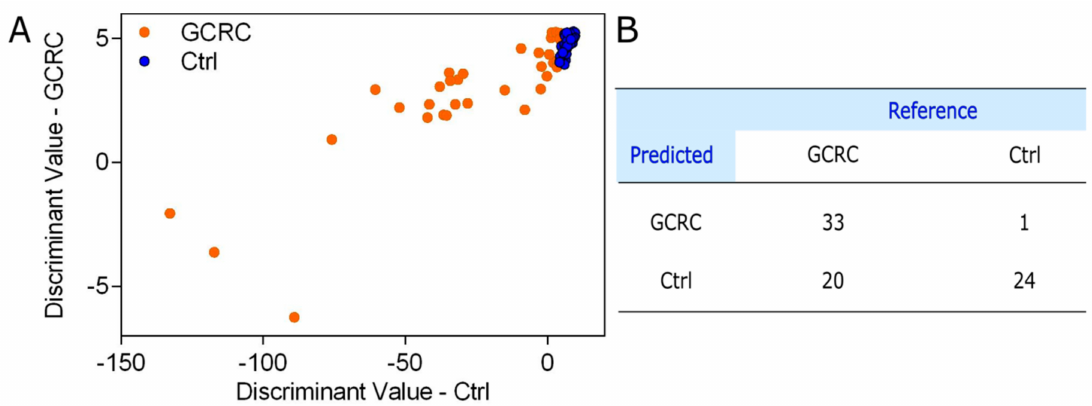
Figure 5. QDA of C-reactive protein (CRP) levels, hemoglobin levels, neutrophil counts and platelet counts. ( A ) The prediction plot of the QDA model combining CRP levels, hemoglobin levels, neutrophil counts and platelet counts from 53 patients with gastric and colorectal cancer (GCRC) and 25 control subjects (Ctrl). ( B ) The confusion matrix yielded by the QDA on CRP levels, hemoglobin levels, neutrophil counts and platelet counts.